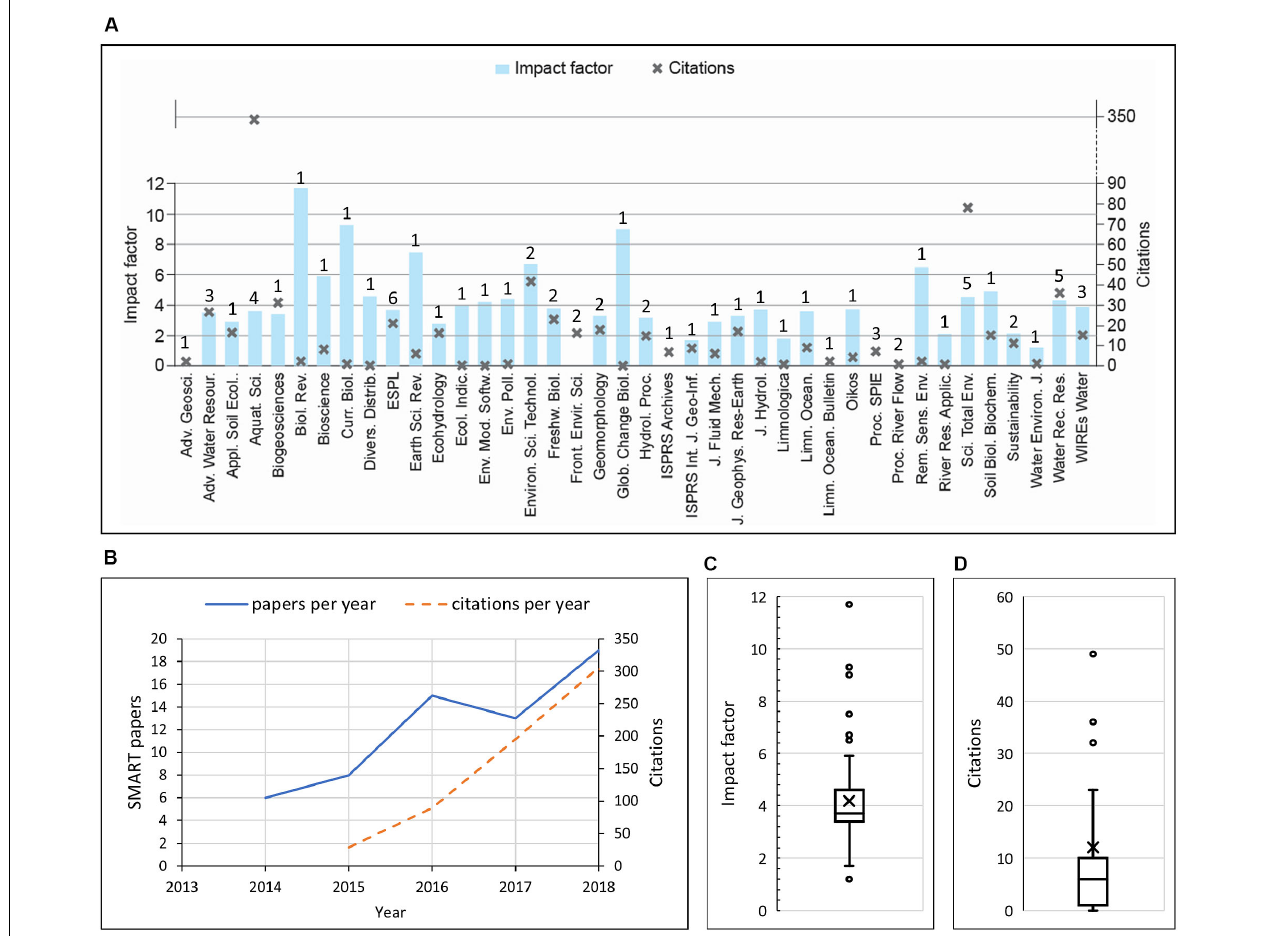
FIGURE 3 | (A) Impact factor and citations per journal or conference proceedings with numbers above bars indicating the total number of published papers within the corresponding journal; (B) papers published in the SMART EMJD and related citations per year; boxplots showing distributions of (C) journal impact factor and of (D) the number of citations for all papers. The horizontal line within the box represents the median, the mean is presented with a cross symbol, outliers as circles, the quartiles are calculated excluding the median (papers and number of citations considered up to March